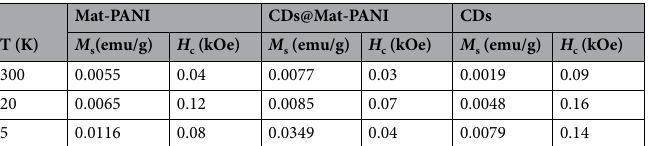
Table 1. Saturation magnetization ( M S ) and magnetic coercivity ( H C ) of Mat-PANI, CDs@Mat-PANI and CDs at 300, 20 and 5